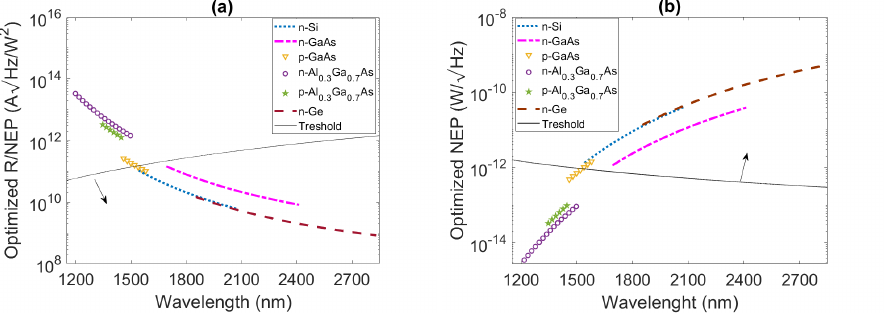
Figure 4. ( a ) The optimized R / NEP and ( b ) the optimized NEP of the Schottky graphene-based PDs for various semiconductors as function of the wavelength range individuated in Table 3. All figures were obtained at room temperature and by considering a graphene circular area in touch with the semiconductor with radius of 500 µ m and a load resistance of 10 M Ω . The arrows indicate the validity regions of the proposed optimization